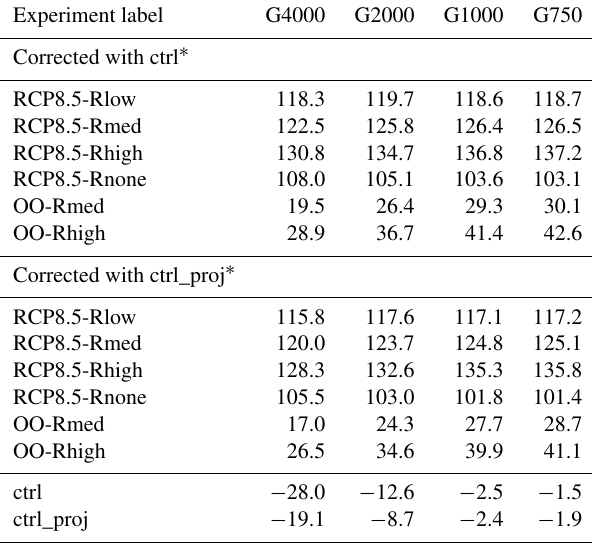
Table 3. Modelled mass change (mmSLE) in future experiments for all experiments.